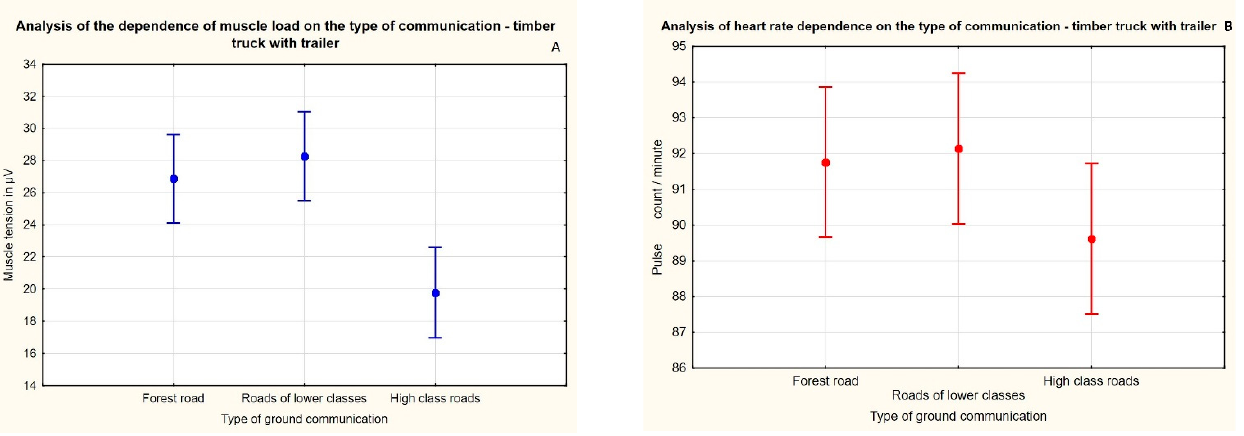
Figure 4. Dispersion analysis of the dependence of muscle load values ( A ) and heart rate ( B ) on the type of communication used when driving the timber truck with trailer (author). Table 5. Post hoc test to analyze the variance of muscle load values depending on the type of communication when driving the timber truck with trailer. Red text indicates statistical significance.